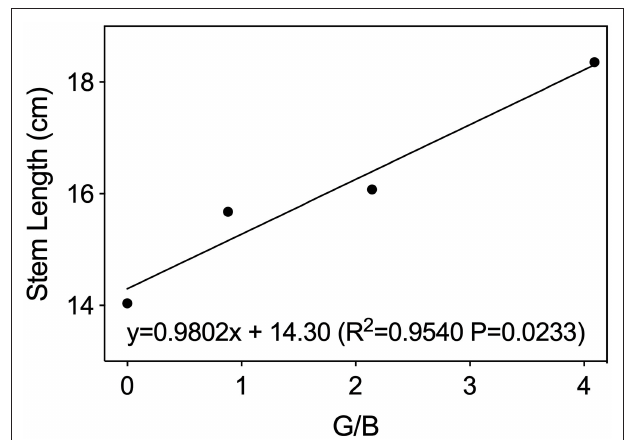
FIGURE 3 | Stem length of lettuce leaves as affected by green-to-blue (G/B) ratio. Associated correlation of coefficients ( R 2 ) and regression equations presented here indicate significant differences at p <